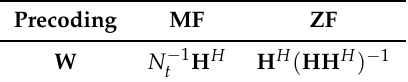
Table 1. The precoding matrices of MF and